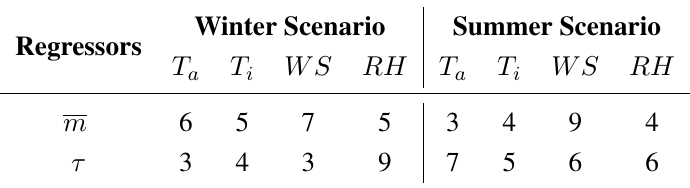
Table 2. Selected (optimal) values of the embedding parameters used for the NNARX